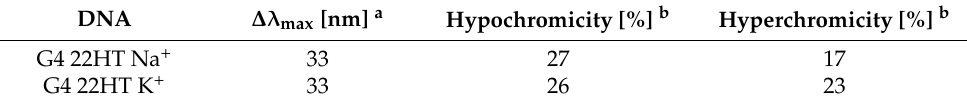
Table 2. Spectral effects for ligand 3 bound to 22HT G-quadruplexes.